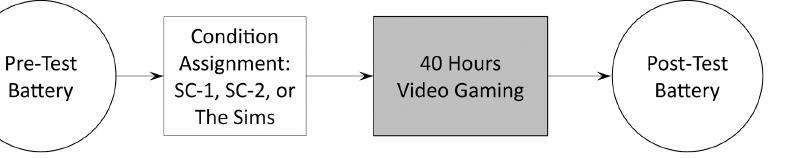
Figure 1. General experimental procedure outline. The experimental procedure included the completion of a pre-test task battery, followed by gaming condition assignment (SC-1, SC-2, or The Sims). Each participant engaged in 40 total hours of video gaming. This video game play occurred outside the lab on the participants’ own laptops. Psychological testing occurred over sessions in the laboratory.